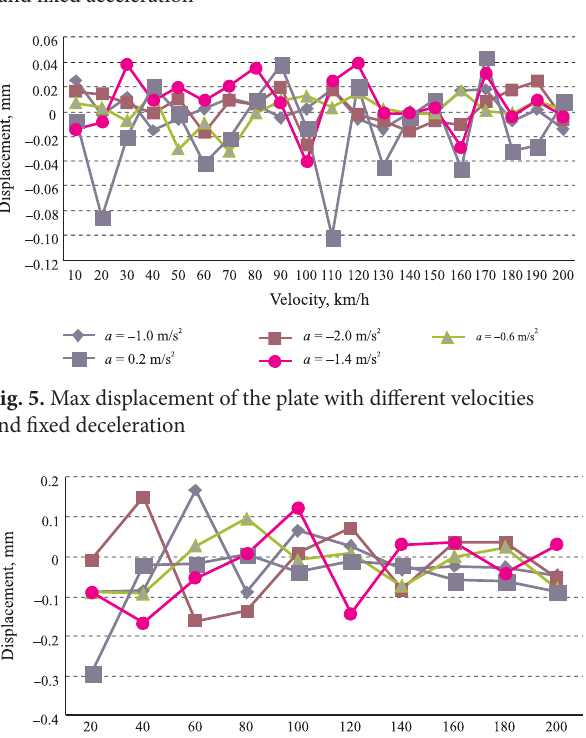
Fig. 4. Max displacement of the plate with different velocities and fixed acceleration